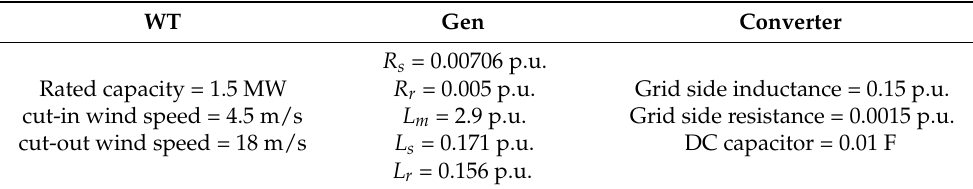
Figure 6. Simulation system. Table 1. Parameters of WT.